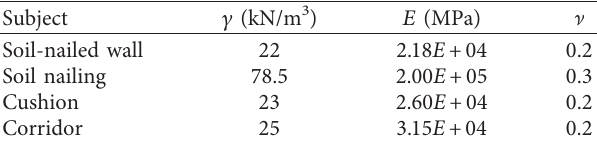
Table 5: Parameters of structures of the utility tunnel.